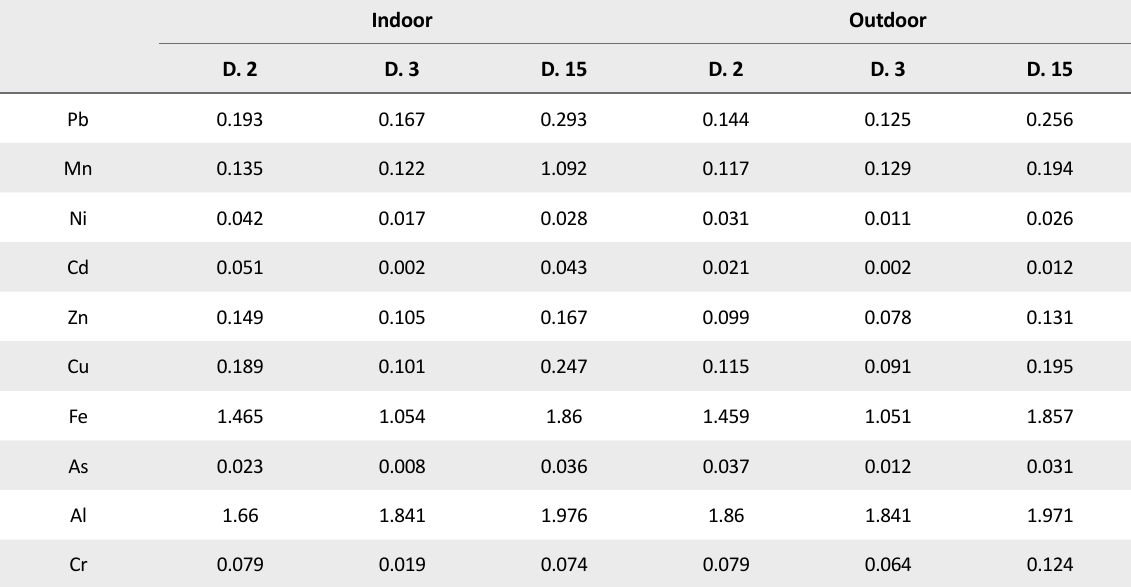
Table 2. Average Concentrations (μg/m 3 ) of heavy metals detected in six stations of high-traffic districts (D.) in Tehran Metropolis,